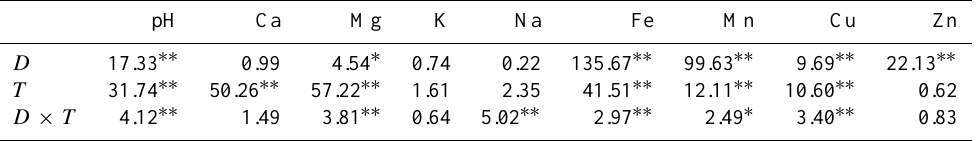
Table 2. Results ( F values) of two-way ANOVAs on the effect of soil depth ( D ), treatments of soil coarseness degrees ( T ), and their interactions on soil base cations (exchangeable Ca, Mg, K, and Na) and available micronutrients (Fe, Mn, Cu, and Zn). pH Ca